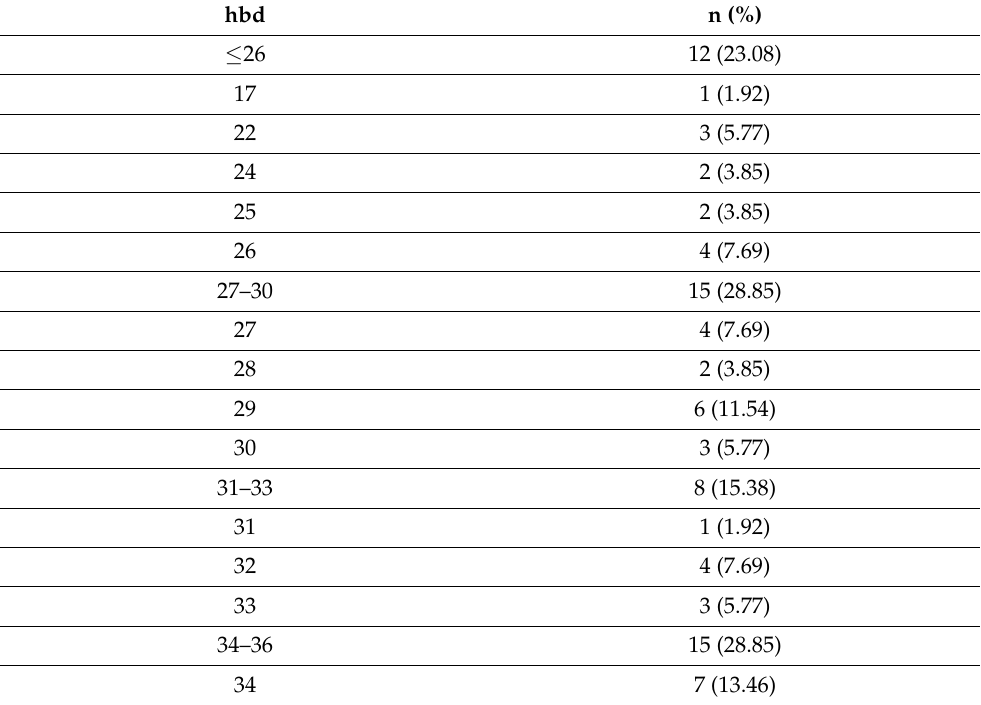
Table 1. Weeks of